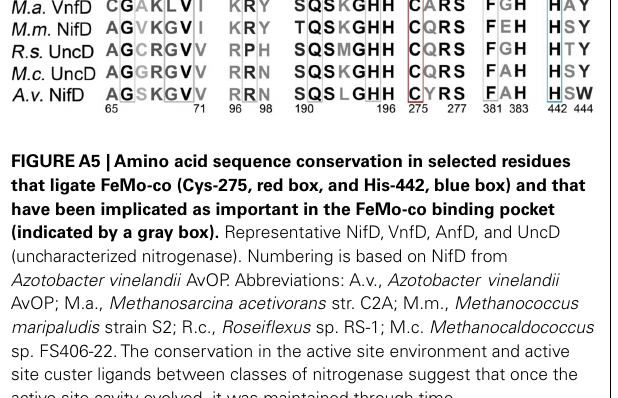
FIGUREA3 | Plot of a Mantel regression of a matrix describing the average RMSD for H, D, and K protein structures inferred using homology modeling as a function of the Rao phylogenetic dissimilarity of concatenated HDK homologs inferred by MrBayes. The strong correlation suggests a relationship between the evolution of sequences and their inferred structures, implying that the HDK structure is evolving.The slope of the line linear regression ( ∼ 2) suggests that the evolution of protein structure is constrained to a greater extent than the evolution of the primary sequences.